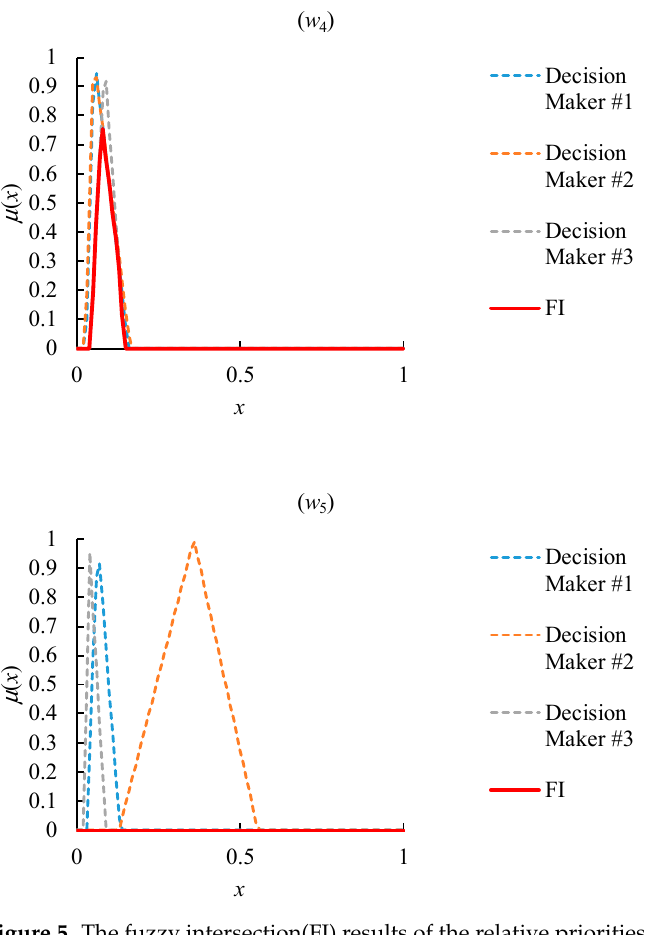
Figure 5. The fuzzy intersection(FI) results of the relative priorities.